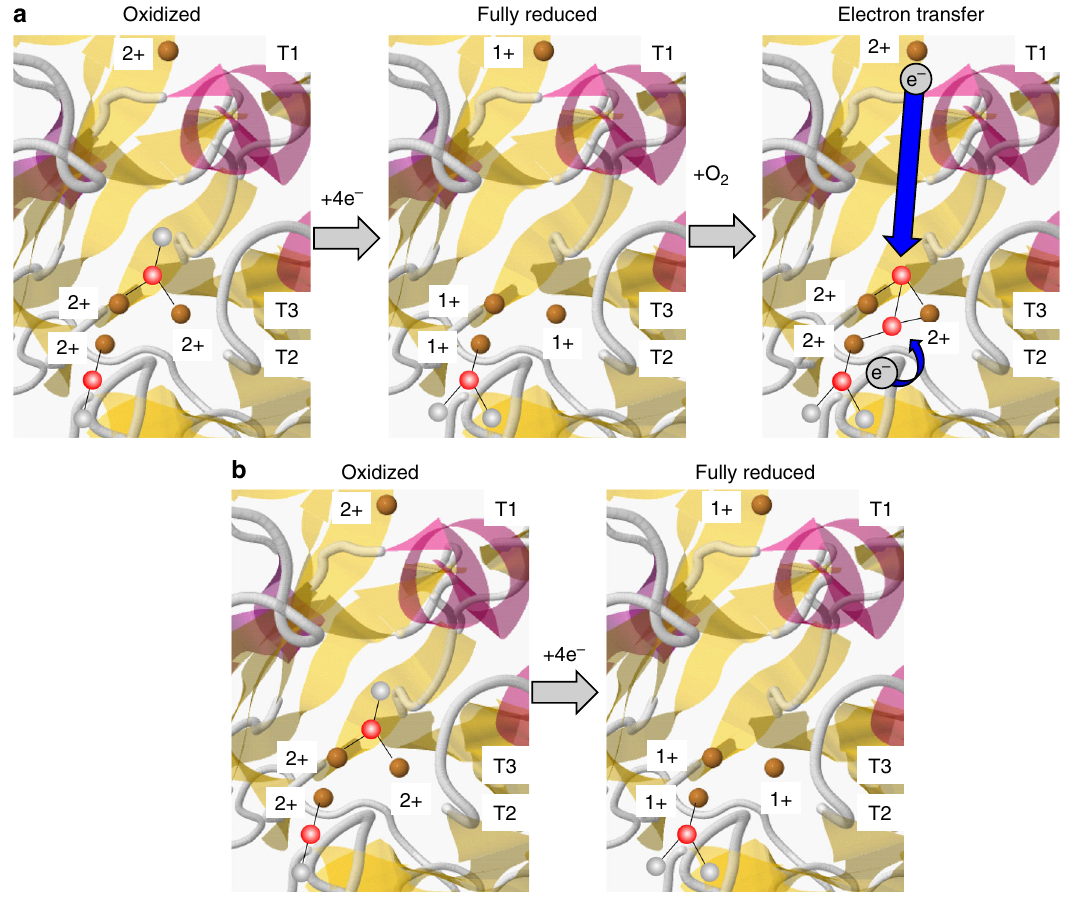
Fig. 6 Simpli fi ed and schematic mechanism of internal electron transfer in Mv BOD. a In the presence and b absence of O 2 bonded to the active site of Mv